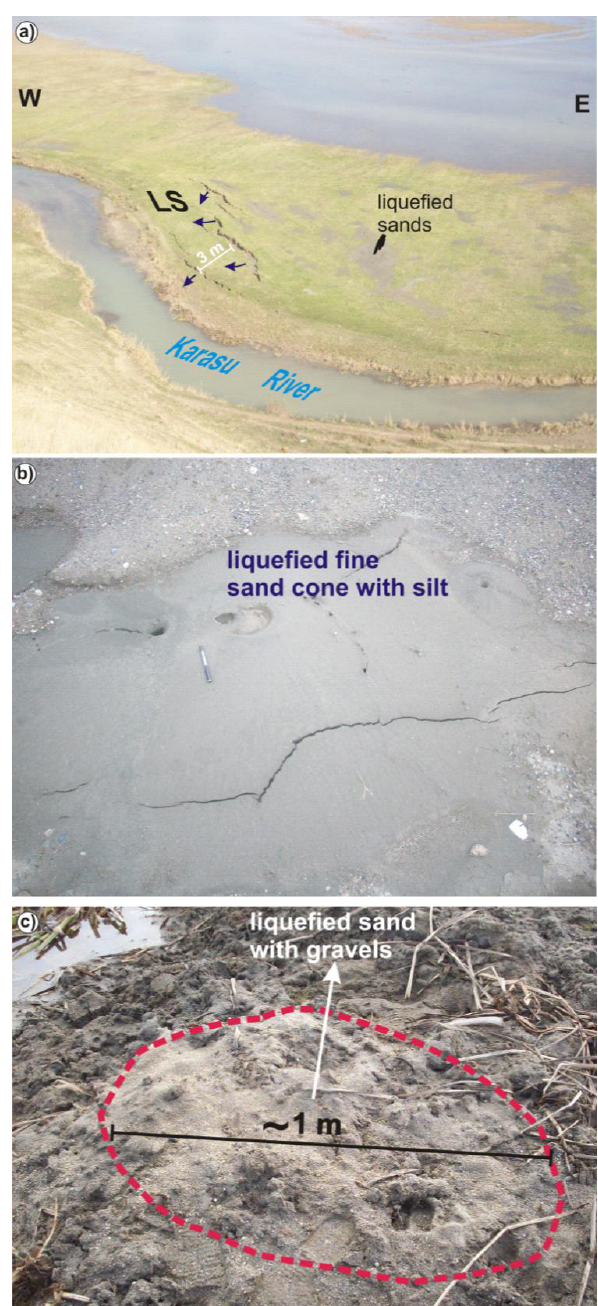
Fig. 10. (a) Sand boils and ejection of liquefied soils into the surface Figure 10. (a) Sand boils and ejection of liquefied soils into the surface through a ground 3 through a ground crack in Karasu Delta, (b) sand cone of liquefied crack in Karasu Delta (b) Sand cone of liquefied fine grained soil in the eastern shores of 4 fine-grained soil in the eastern shores of Lake Van around C¸it ¨ oren Lake Van around Çitören Village (c) Sand boil of liquefied sand with gravels in the northern 5 village, and (c) sand boil of liquefied sand with gravels in the north- shores of Lake Van around south of Çelebibağı. 6 ern shores of Lake Van around south of C¸